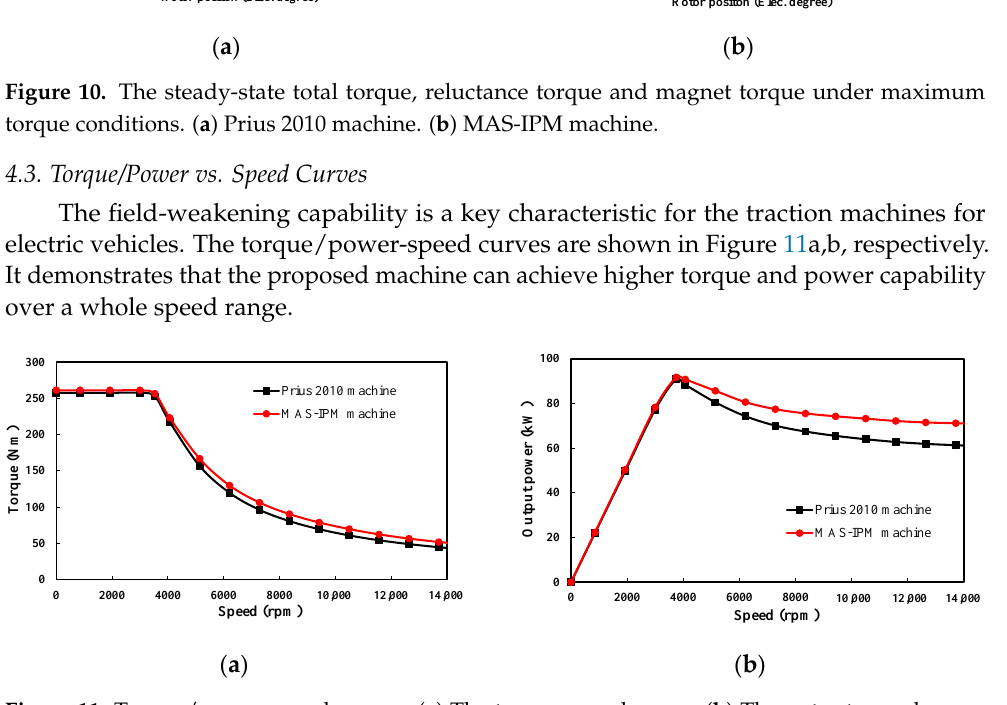
Figure 11. Torque/power-speed curves. ( a ) The torque-speed curve. ( b ) The output-speed curve. (I max = 246 A, U dc = 650 V).